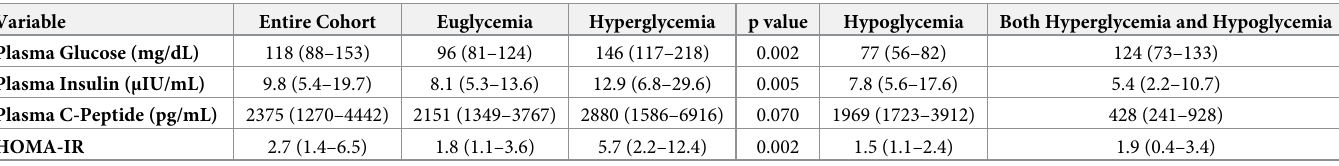
Table 2. Glycemic measures at the time of biomarker collection.